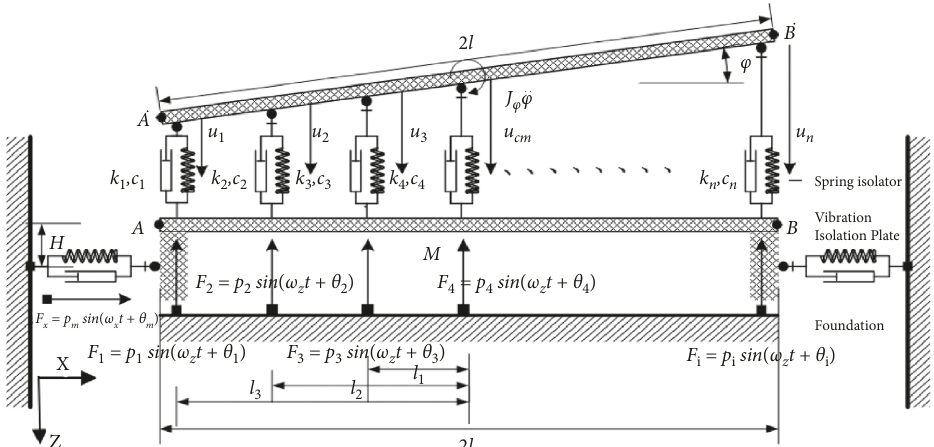
Figure 1: Multi-dimensional vibration isolation system (Front view).